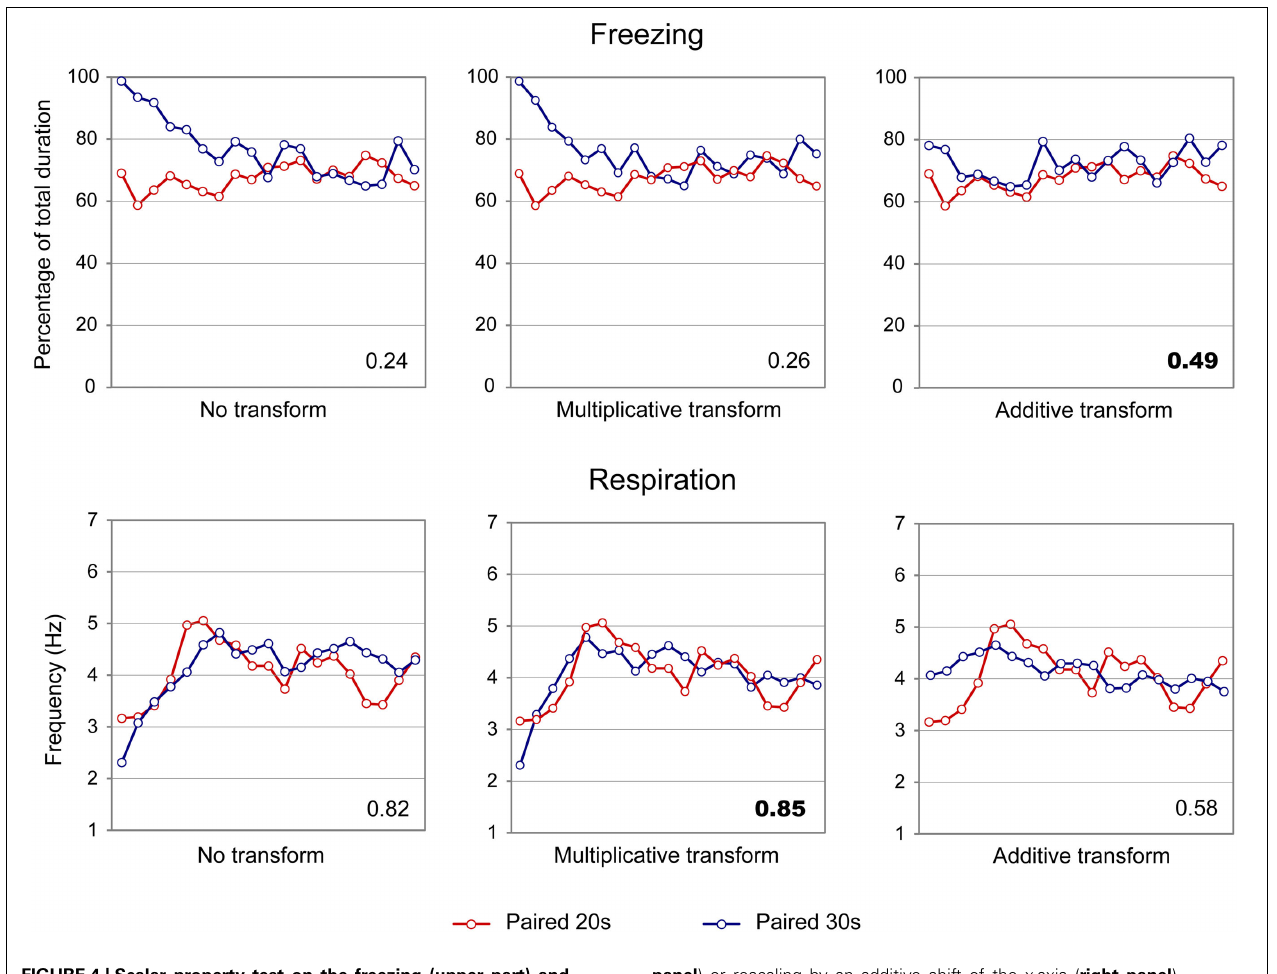
panel ) or rescaling by an additive shift of the x-axis ( right panel ). Superposition between the two curves was indexed by eta-square ( η 2 ) indicated in the bottom right of each graph, the highest values being highlighted in bold